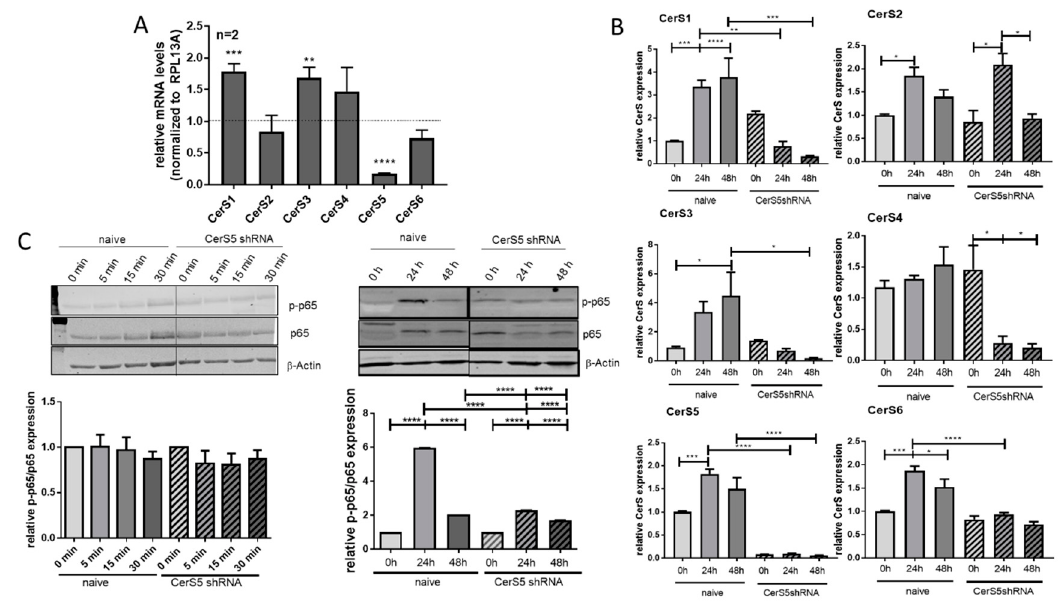
Figure 6. Activation of Jurkat cells is prohibited by CerS5 downregulation. ( A ) Transduction of CerS5-shRNA into Jurkat cells led to a significant reduction of CerS5 mRNA expression. ( B ) CerS mRNA expression was increased after stimulation of Jurkat cells with IL-2 (200 Units / mL) and anti-CD2 / 3 / 28 activation beads (1:1 beads-to-cell ratio) for 24–48 h. This was inhibited by CerS5 downregulation. ( C ) NF- κ B activation in Jurkat cells after treatment with IL-2 (200 units / mL) and anti-CD2 / 3 / 28 activation beads (1:1 beads-to-cell ratio) for 0–48 h. NF- κ B activation was detected by anti-phospho-p65 and anti-p65 antibodies by Western blot method. Data from (A) and (B) are mean ± SEM of 2–4 independent experiments measured in triplicate. ( C ) One representative blot is shown of three to five. For calculation, the expression levels of p -p65 and p65 were related to β -actin and subsequently related to untreated control cells. Data are mean ± SEM. Statistical analysis was performed by one-way ANOVA. p * = 0.05, p ** = 0.01, p *** = 0.001, p **** = 0.0001. The whole western blot image please find in Figure